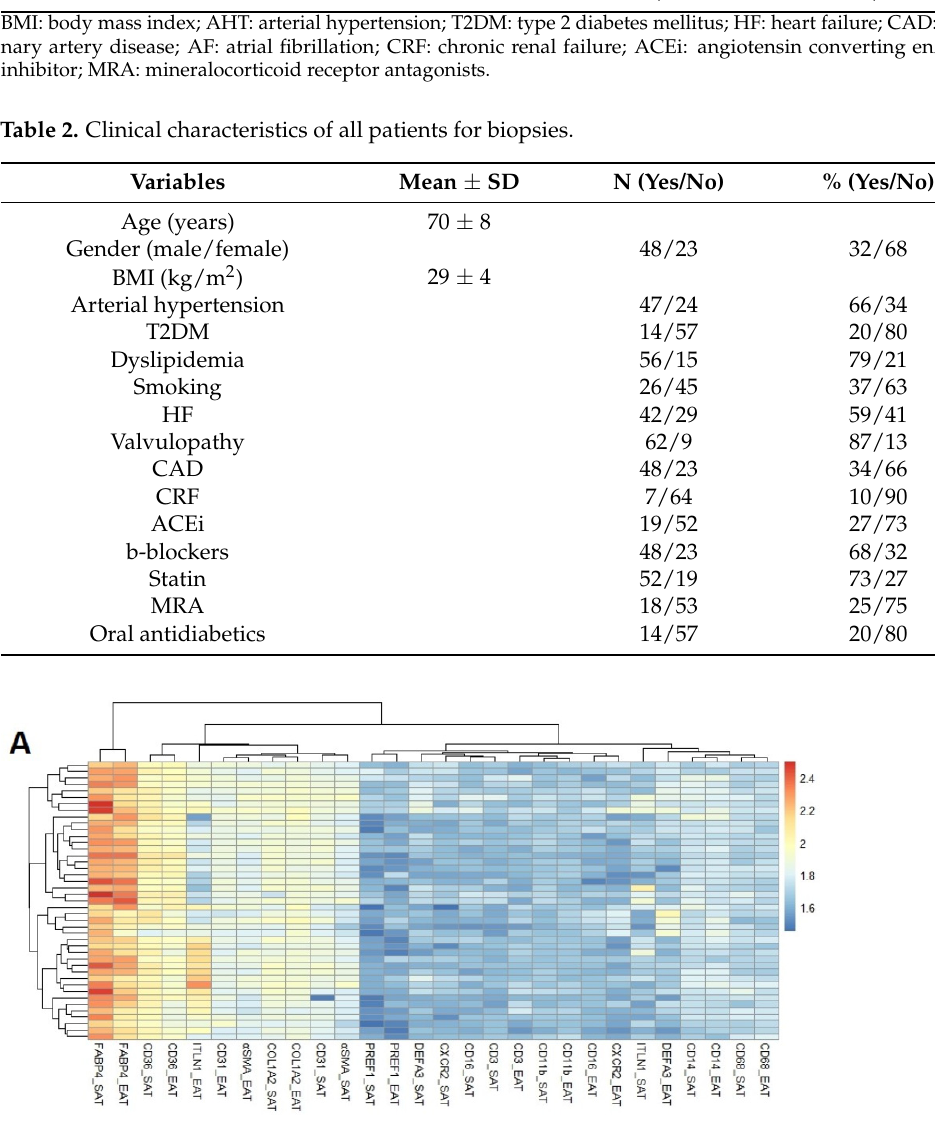
Table 2. Clinical characteristics of all patients for biopsies.